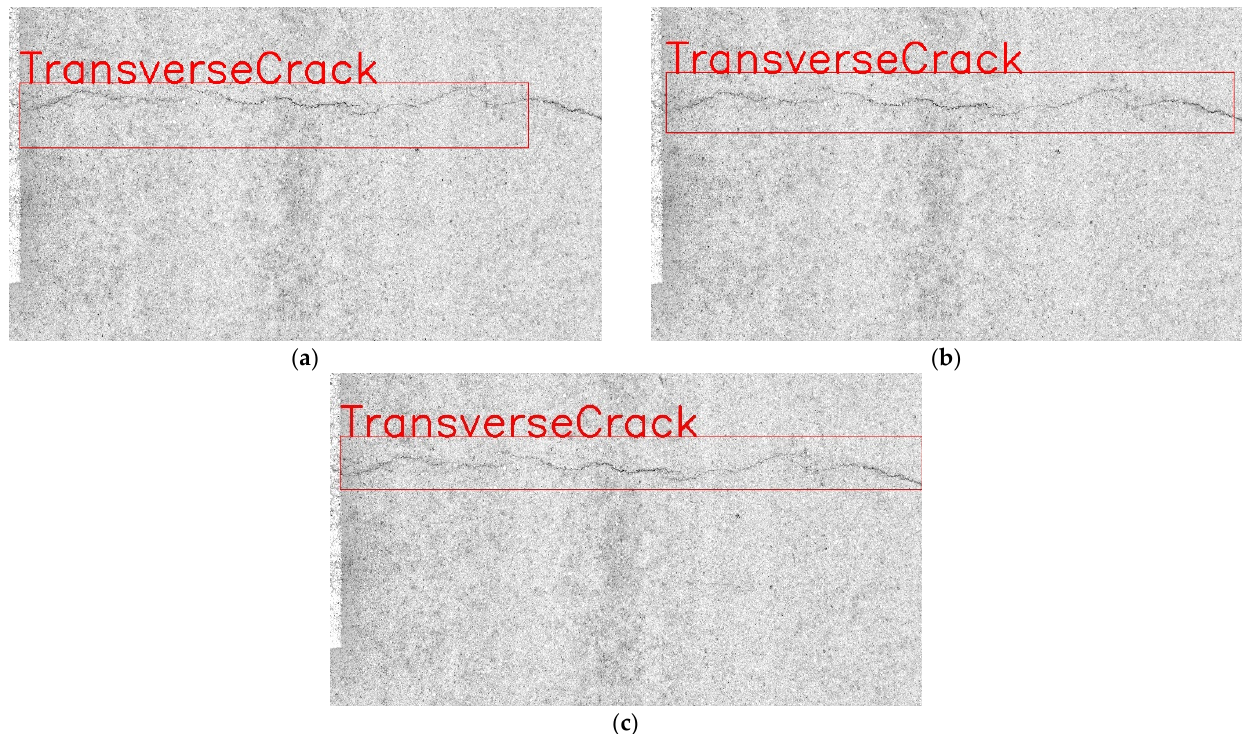
18 of 31 Table 3. Ablation experimental results. Network/Index